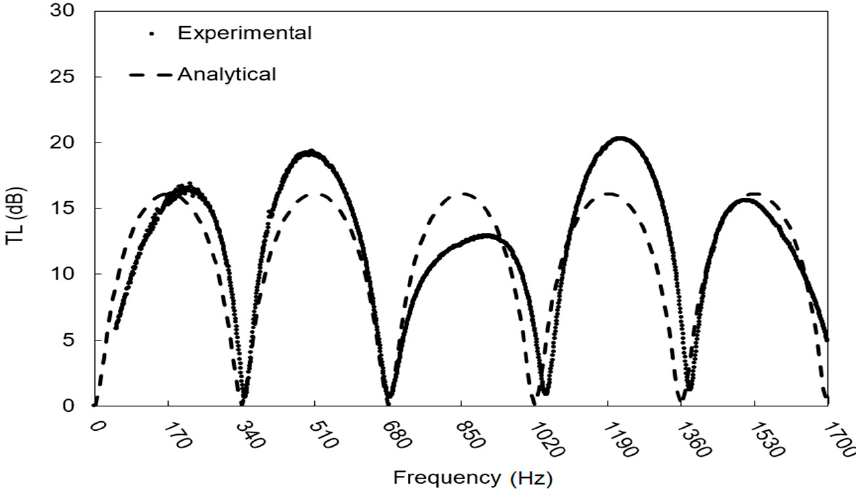
Figure 10. Comparison of analytical and experimental TL curves for the expansion chamber.